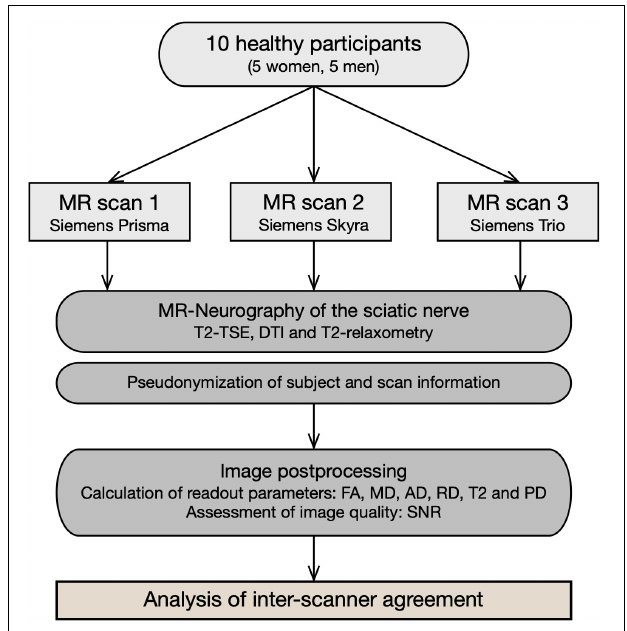
FIGURE 1 | Flowchart of study design. Ten healthy participants underwent repeated multiparametric MR neurography of their sciatic nerve using three different MR scanners. Subsequent image analysis included standardized post-processing algorithms and quantitative assessment of DTI and T2 relaxometry parameters. Finally, inter-scanner agreement was analyzed, and results are expressed in the form of ICC and